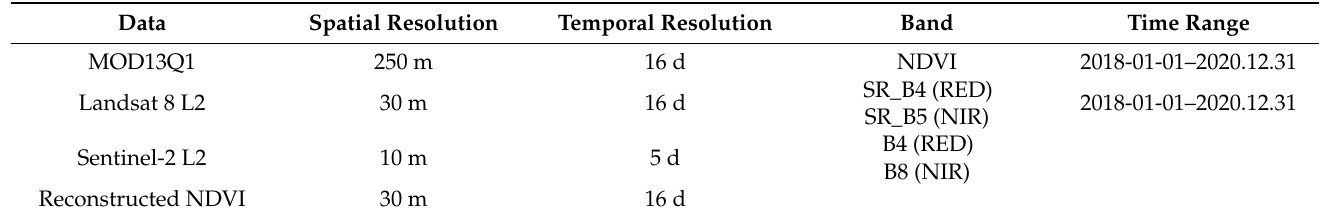
Table 1. The satellite data used in this study and the spatial and temporal resolution of the recon- structed